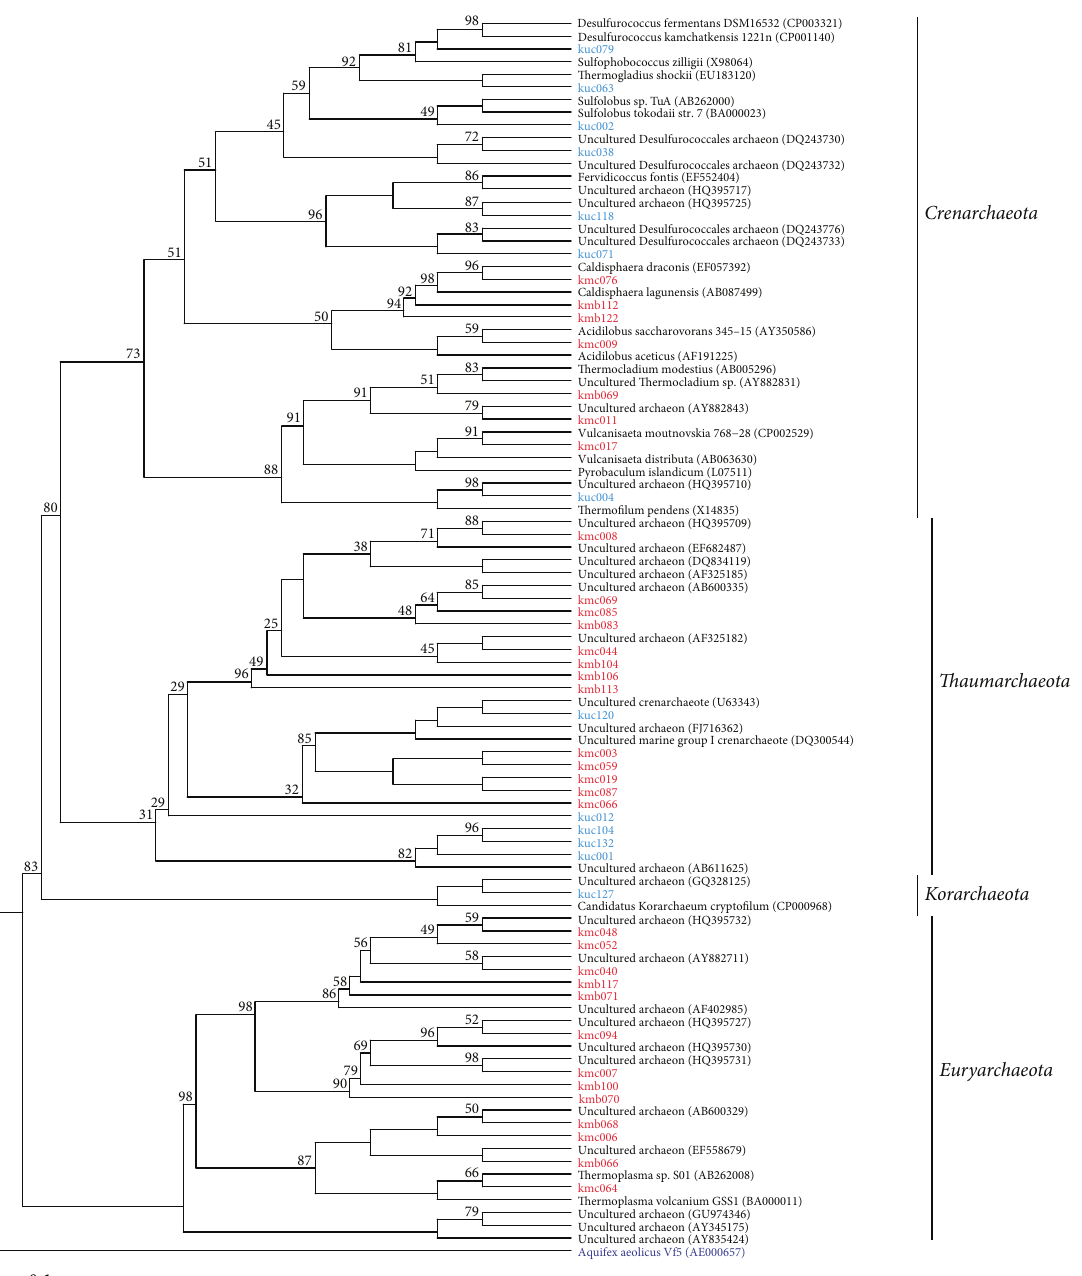
Figure 2: Maximum parsimony phylogenetic tree based on all archaeal 16S rRNA gene sequences. The tree was calculated using the ARB software package [33]. Sequences are characterized by sample designation (km, Kamchatka Mutnovsky; ku, Kamchatka Uzon Caldera), length of amplicon ((b), 730 bp; (c), 950 bp), number of sequence, and accession number. Sequences derived from the Mutnovsky sample are shown in red and those from the Uzon sample in blue. Numbers at branch nodes are bootstrap values (only values ≥ 25 are shown). The tree is rooted with the 16S rRNA gene sequence of Aquifex aeolicus Vf5 as an outgroup .